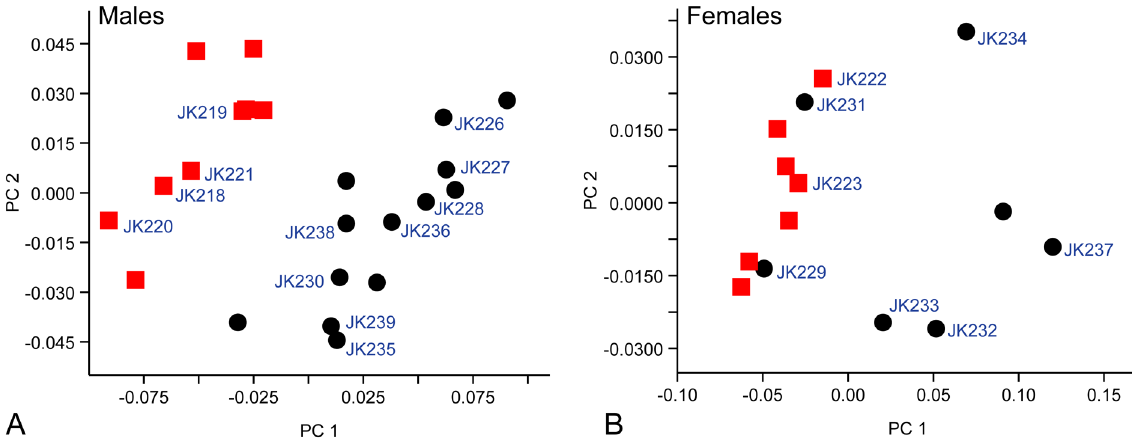
Fig. 3. Ordination of Elmomorphus brevicornis Sharp, 1888 (black circles) and Elmomorphus amamiensis Nomura, 1959 (red squares) along PC1 and PC2 axis. A . Males. B .